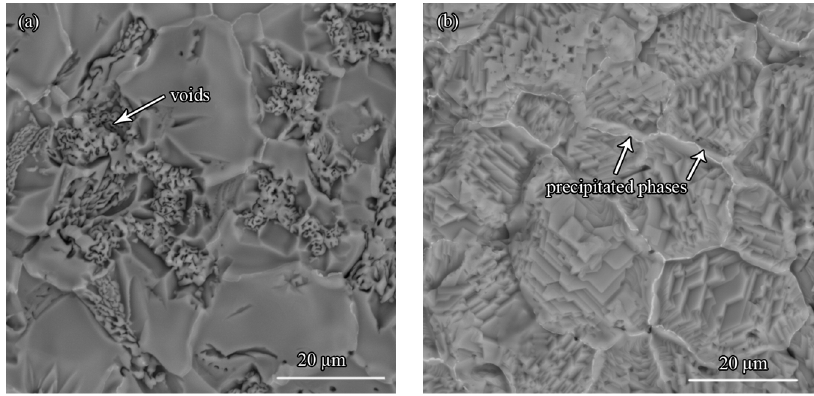
Figure 4. The surface morphologies of the coatings after aluminization: ( a ) PtAl; ( b ) PtZrAl.